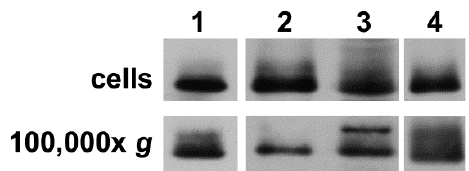
Figure 3. Cx43-expressing primary cells and cell lines secrete extracellular vesicles containing Cx43. Cell homogenates and the pellets from 100,000× g centrifugation of conditioned media were prepared as described for hCMEC/D3 cells in Materials and Methods from (1) human dermal microvascular endothelial cells, (2) human dermal fibroblasts, (3) human oligodendroglioma (HOG) cells, and (4) human glioblastoma (A172) cells. Samples were resolved by SDS-PAGE and transferred to membranes that were reacted with anti-Cx43 antibodies as described in Materials and Methods. Immunoblots show the presence of Cx43 protein in all cell homogenates and secreted vesicles.